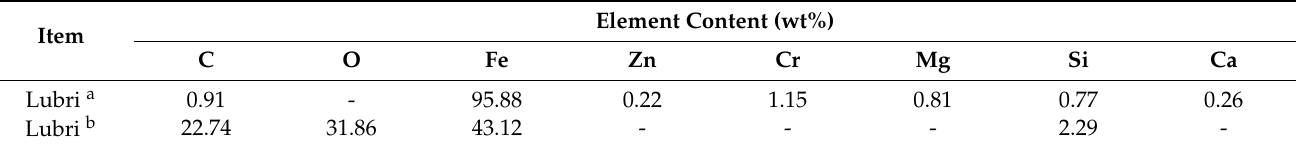
Table 3. EDS analysis of the cylinder liner wear zones lubricated with 20 vol% and 80 vol% EBF in FFEO.